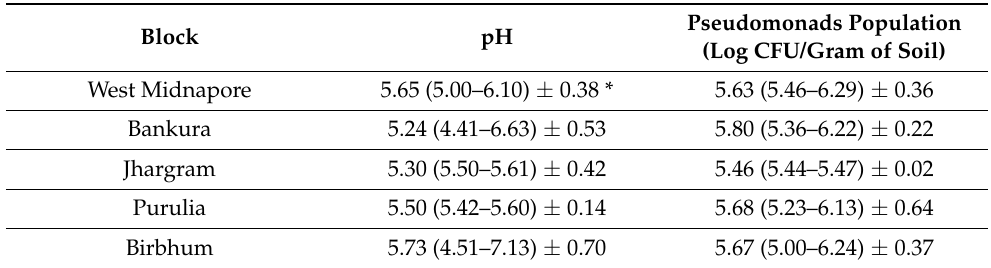
Table 1. Soil pH and population of Pseudomonads and related genera at surveyed red and lateritic areas of West